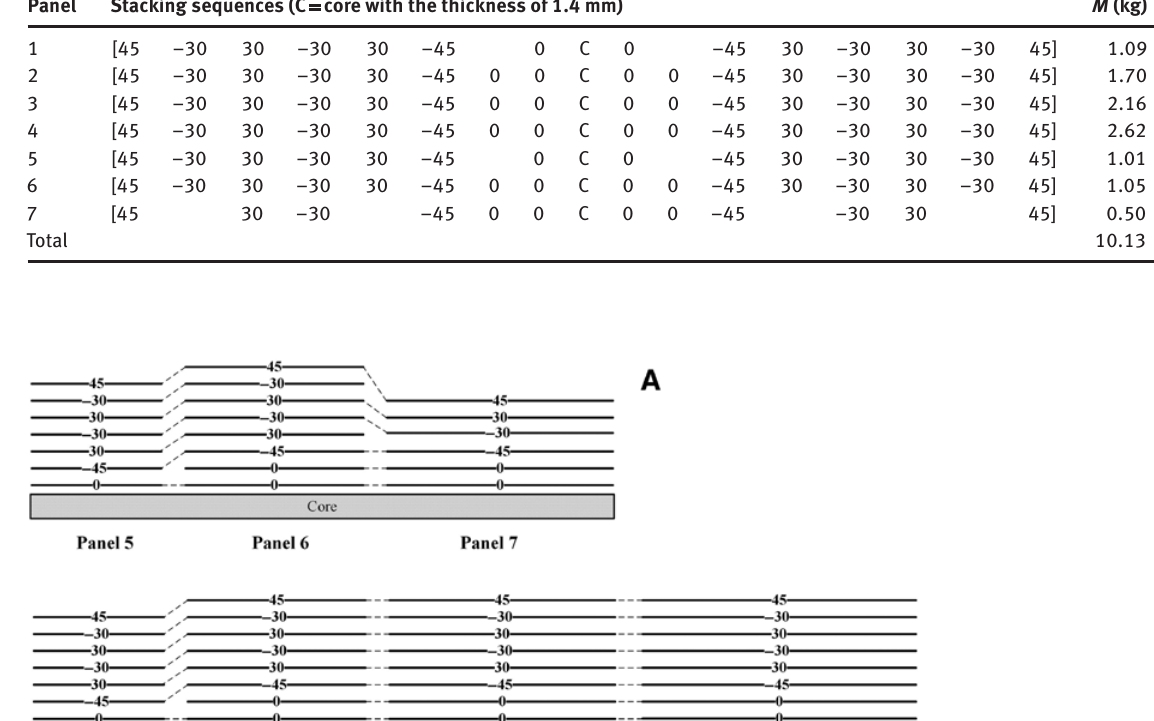
Table 4: Optimization results for the seven-sandwich-panel structure with identical core thicknesses. Panel Stacking sequences (C = core with the thickness of 1.4